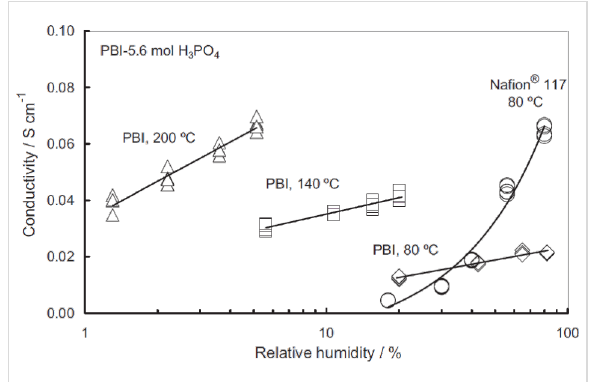
Figure 5: Conductivity of acid-doped PBI and Nafion as a function of humidity at various temperatures. Reproduced with permission from [23]. Copyright 2004 Wiley-VCH.